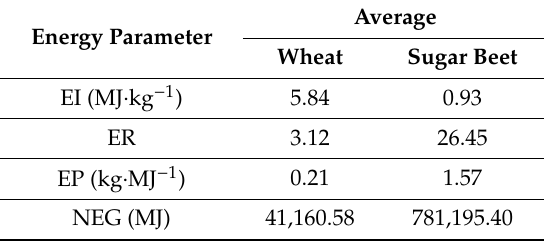
Table 2. Energy parameters for wheat and sugar beet production.